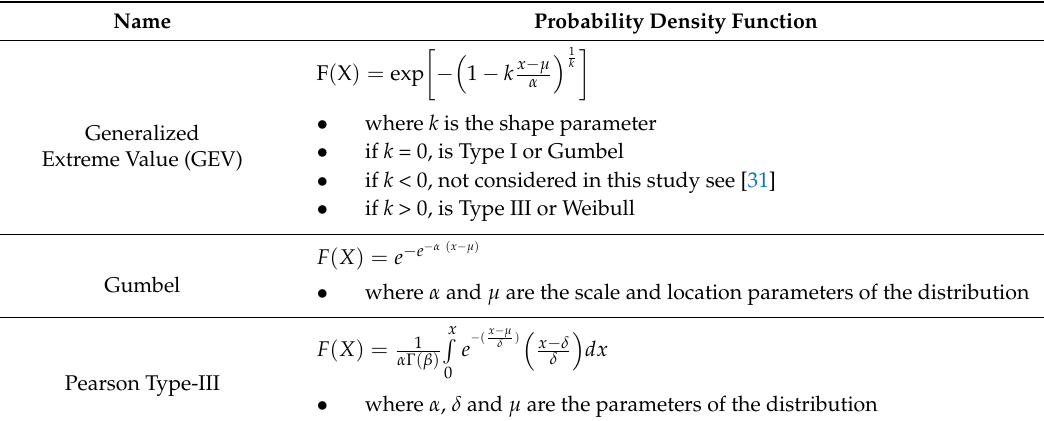
Probability density functions available in web-based system for the estimation of intensity–duration–frequency (IDF) curves (WEBSE IDF